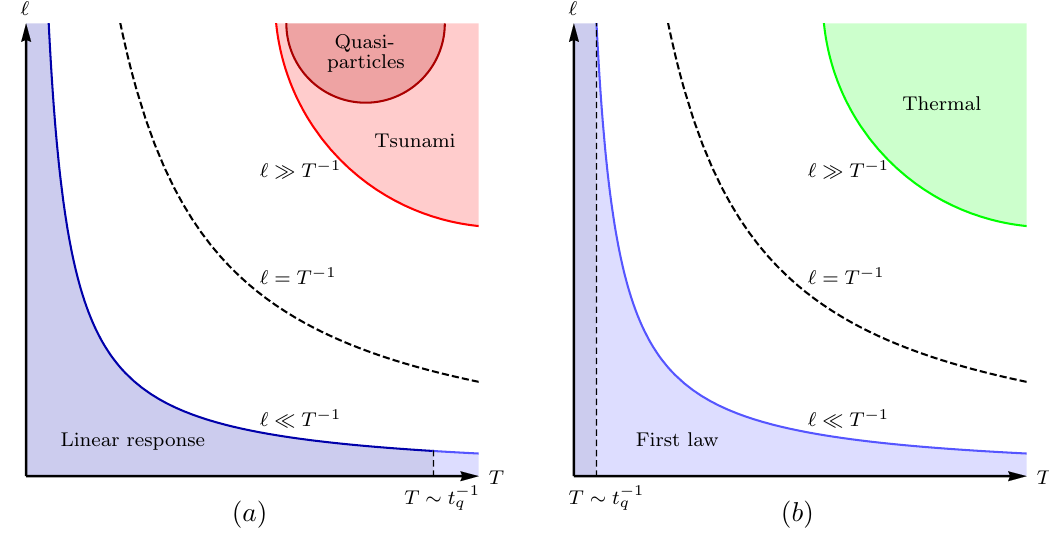
Figure 8 . Schematic diagram of the di(cid:11)erent regimes of interest of entanglement propagation for ( a ) fast quenches t q 0 and ( b ) slow quenches t q . The blue region corresponds to the small ! ! 1 subsystem limit. The dashed vertical line in this region is a separatrix that signals the point at which the (cid:12)rst law of entanglement starts to be valid. The dashed regions in the upper right corners correspond to the large subsystem limit. For fast quenches the spread of entanglement this region is well described by the heuristic entanglement tsunami picture, however in some special cases it admits an microscopic interpretation in terms of quasi-particles. For su(cid:14)ciently slow quenches the system can be considered very close to equilibrium so the standard rules of thermodynamics